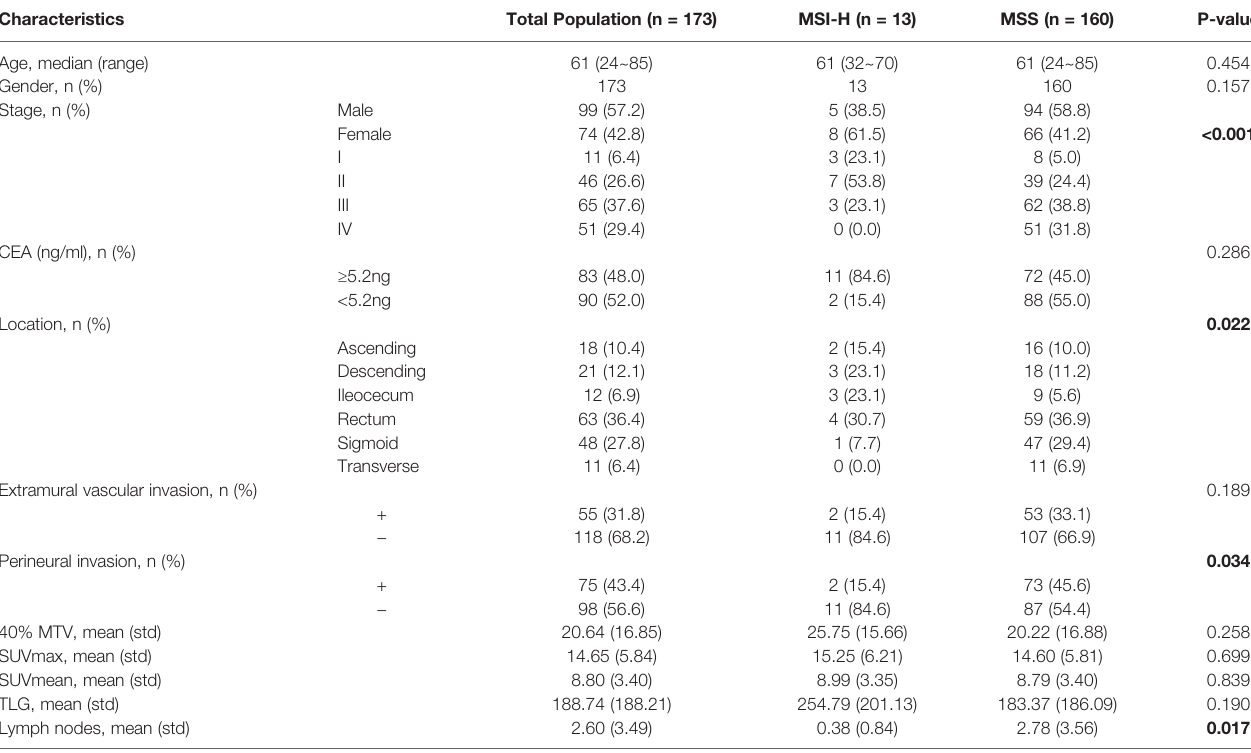
TABLE 1 | Demographic and clinical characteristics of study subjects.